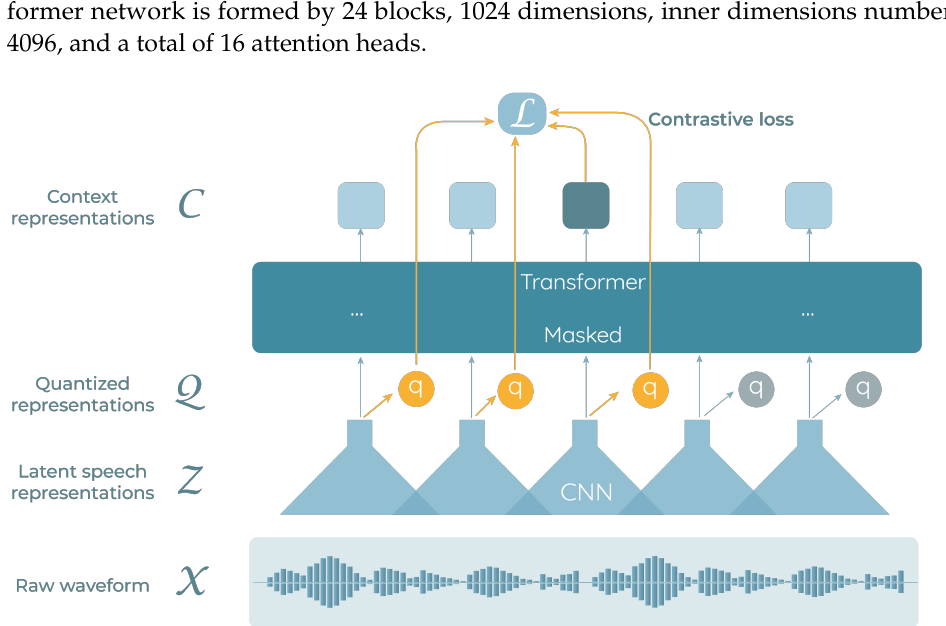
Figure 1. Wav2vec2.0 architecture representation. The raw audio signal is mapped to speech representations that are fed into a transformer network to output context representations. Figure based on the one presented in